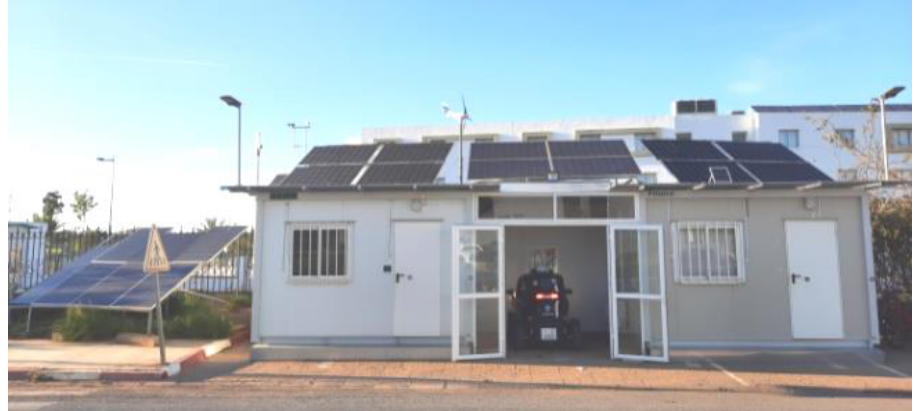
Figure 3. Image of the considered specimen (EEBLABs).